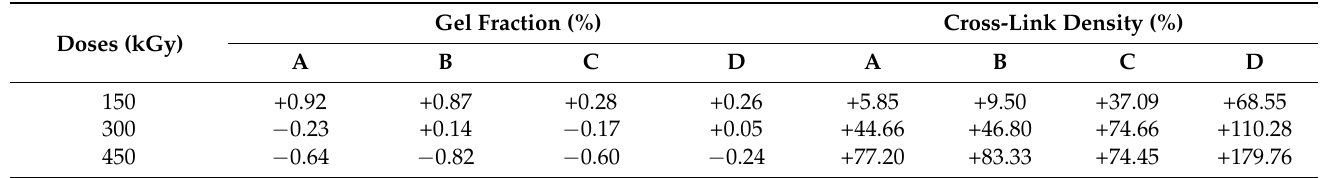
Table 3. Modifications of gel fraction and cross-link density percentages of the irradiated mixtures, reported to be corresponding to the non-irradiated